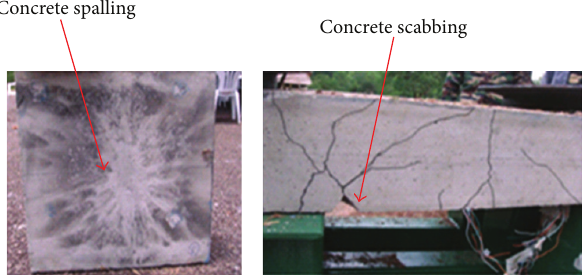
Concrete spalling